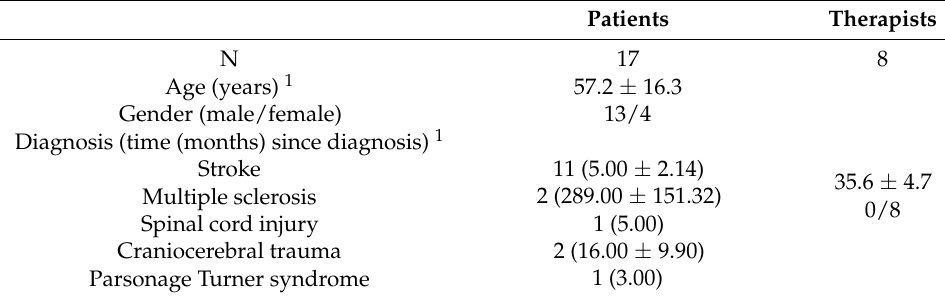
Table 2. Patient and therapist